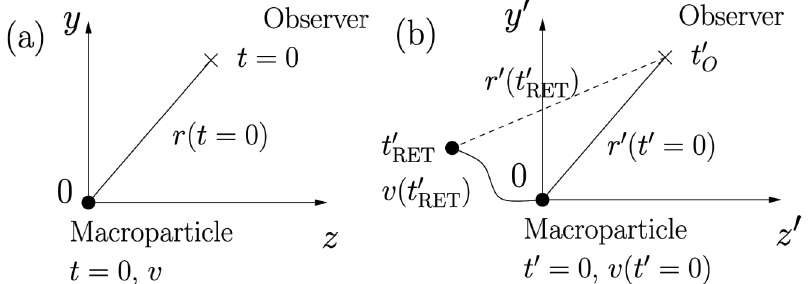
FIG. 5. (a) Two macroparticles in the laboratory frame are shown. Their respective positions are shown at the present time; consistent with the assumptions in the PPI method. (b) Corresponding two macroparticles in the frame comoving with the macroparticle located at the origin (we discuss the electromagnetic fields emitted by the latter and seen by the observer, assumed to be located at the position of the second macroparticle). r 0 (cid:2) t 0 (cid:1) 0 (cid:3) is the actual distance used to calculate the force in the PPI method; the latter would be exact if the macroparticle had a constant velocity during the time interval it takes the light to travel from the macroparticle to the point of observation. For the case of a velocity spread the macroparticle was located at another position than the origin at t 0 (cid:1) t 0 is the retarded time. This is the error introduced in the PPI method, explained using geometrical arguments. Note that retardation effects are not neglected in the PPI method but simply approximated as explained above.